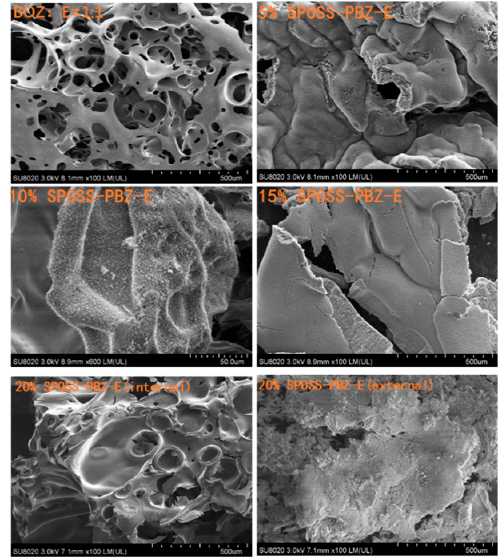
Figure 14. SEM micrographs of the char residues remaining after the cone calorimeter test of the SPOSS-BOZ-E nanocomposites.